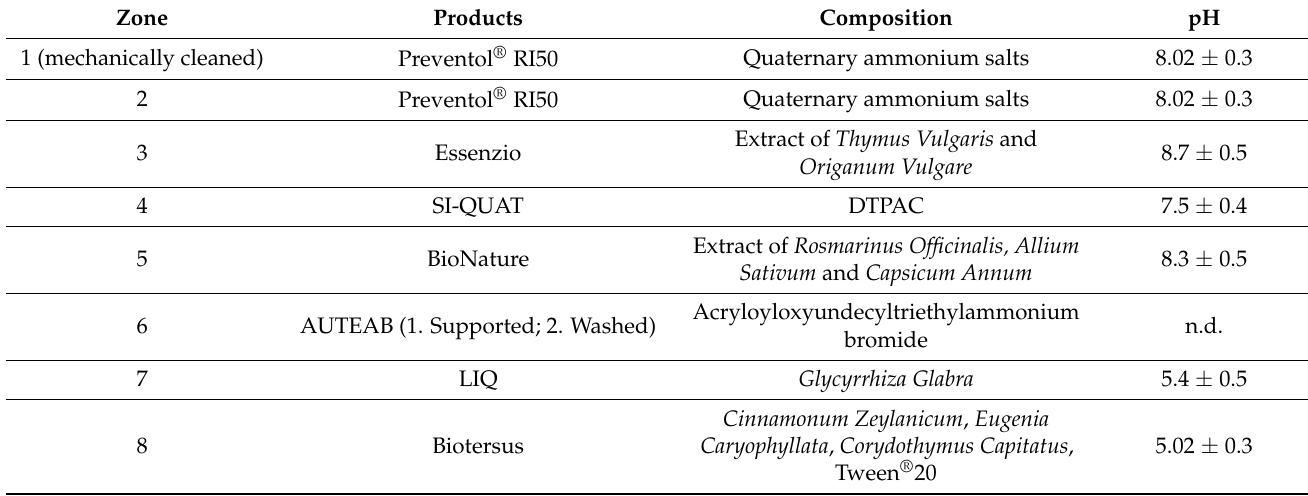
Table 1. Products used in the experimentation and their zone of